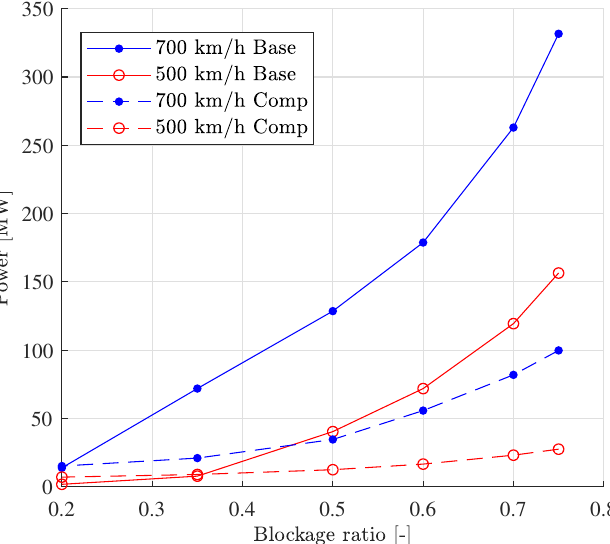
Figure 10. Required power comparison for the different blockage ratios and speeds, at 0.1 atm.